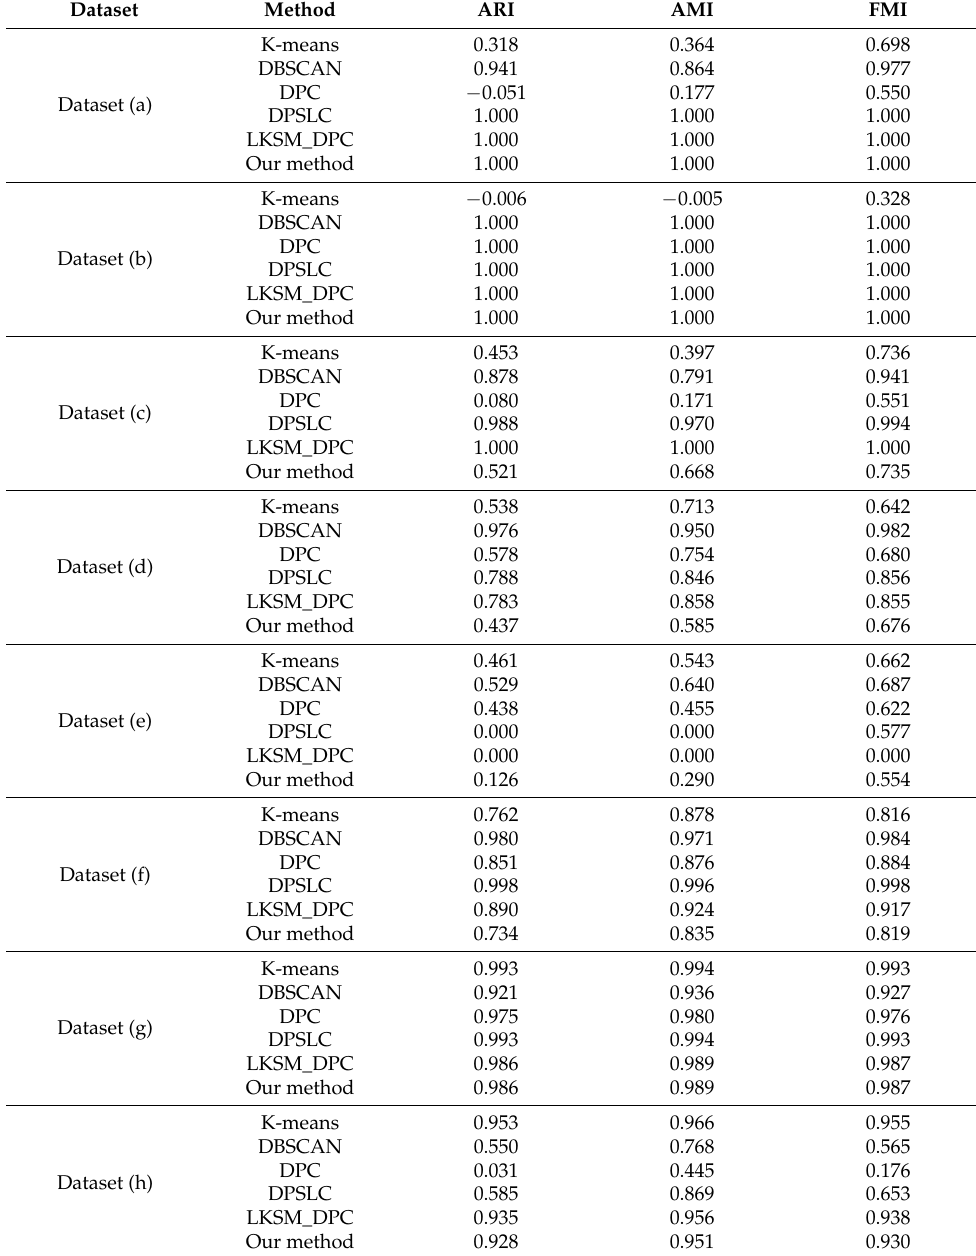
Table 1. Clustering evaluations on dataset